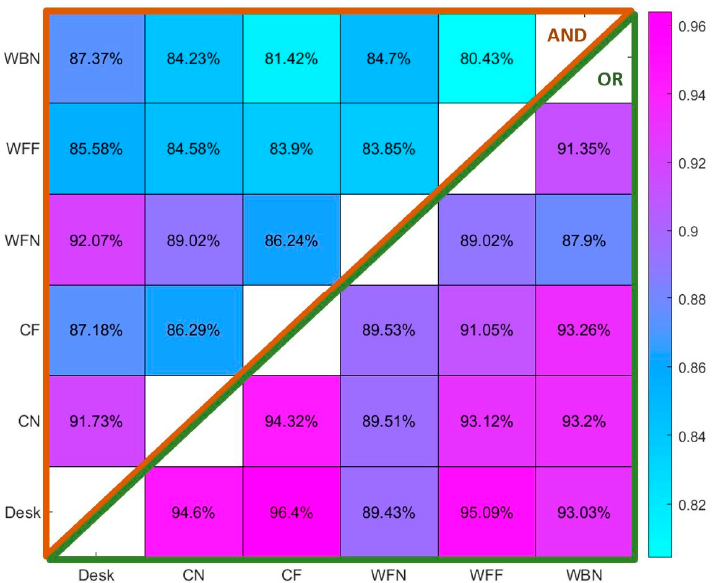
Figure 4. Overall accuracy of occupancy detection by pairwise fusion of PIR sensors.